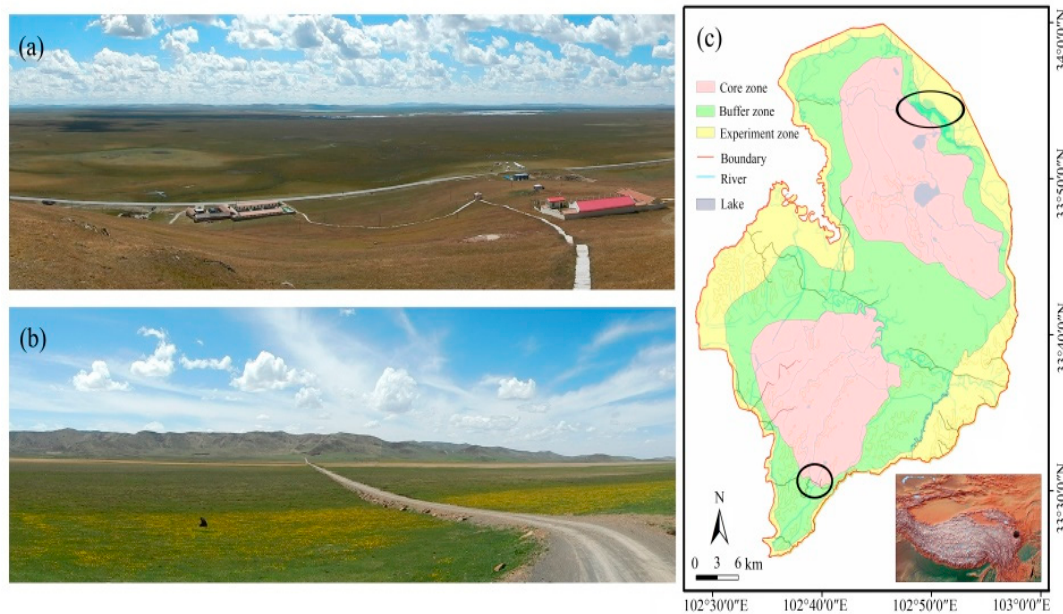
Figure 1. Study area in Zoige wetland on the Qinghai–Tibetan plateau. ( a ) Flower marsh (photo taken on 14 September 2015); ( b ) Naleqiao marsh (photo taken on 20 May 2016); ( c ) map of Zoige wetland nature reserve (upper black ellipse, Flower marsh; lower one, Naleqiao marsh).